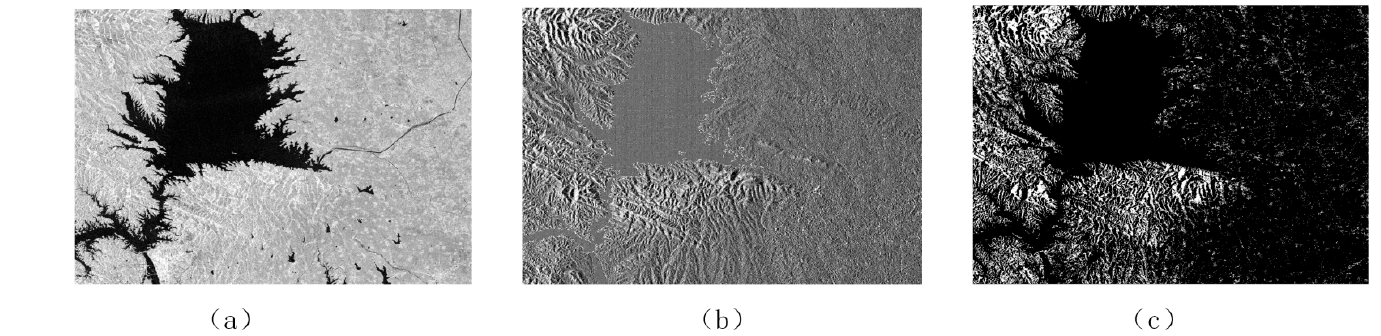
Figure 11. Gafen-3 image and detected geometric distortion area: ( a ) Gaofen-3 HV polarized image; ( b ) local incident angle; ( c ) detected layover and shadow area;.